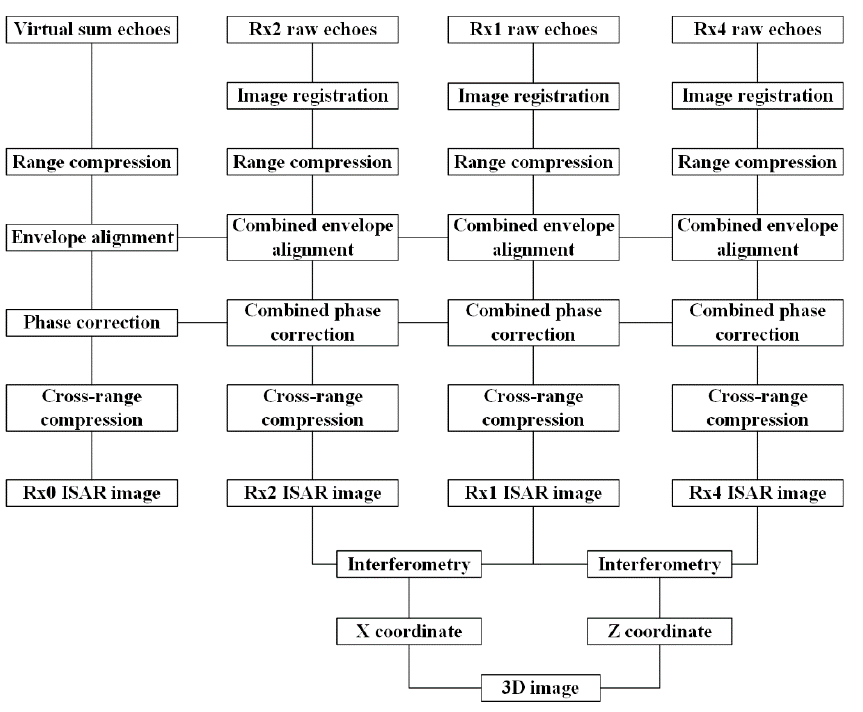
Figure 6. The interferometric inverse synthetic aperture radar (InISAR) imaging processing flowchart based on combined motion compensation.